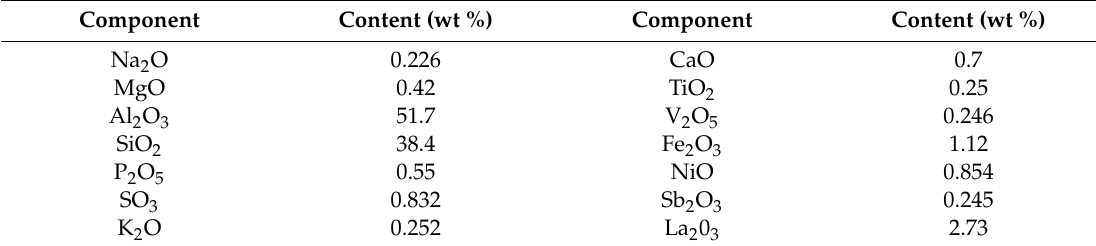
Table 2. X-ray fluorescence semiquantitative